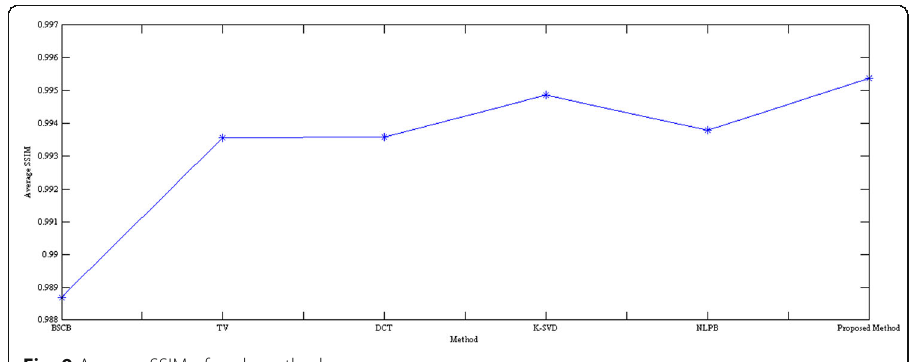
Fig. 9 Average SSIM of each